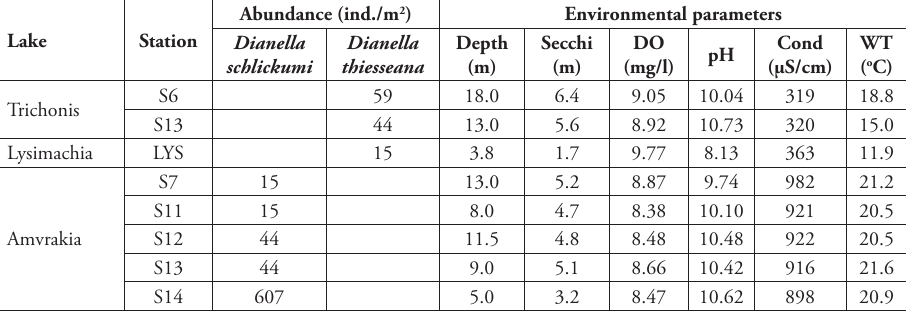
Table 2. Dianella schlickumi and Dianella thiesseana abundances (number of individuals sampled by Ekman-Birge grab, 225 cm 2 sampling area) per sampling station and environmental parameters measured in lakes Trichonis, Lysimachia and